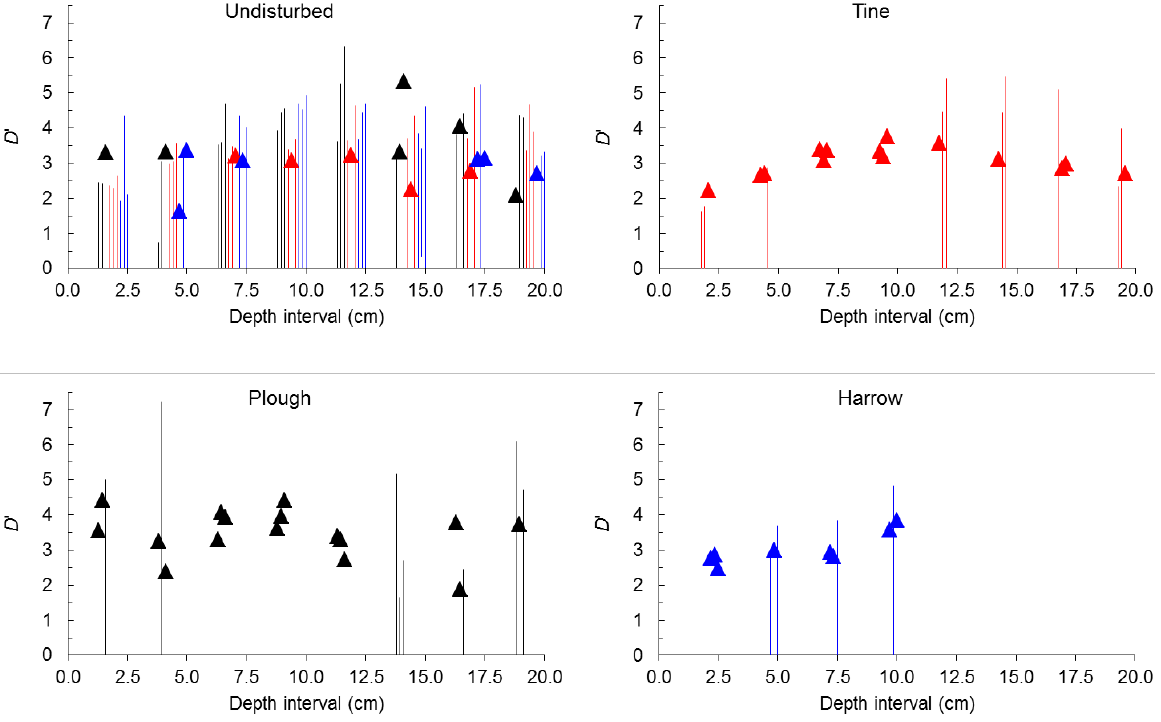
Figure 4. Value (points) or range (bars) of size-number distributions of seeds expressed by D ’ for non-spherical seeds before tillage (undisturbed) and after tine, harrow or plough at 2.5 cm depth